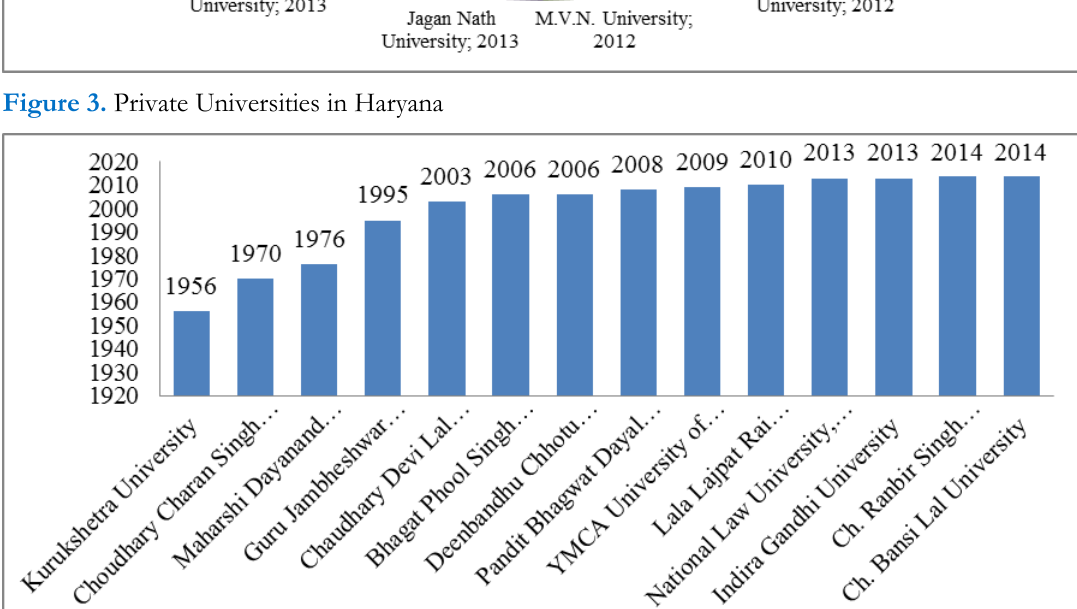
Figure 4. Government Universities in